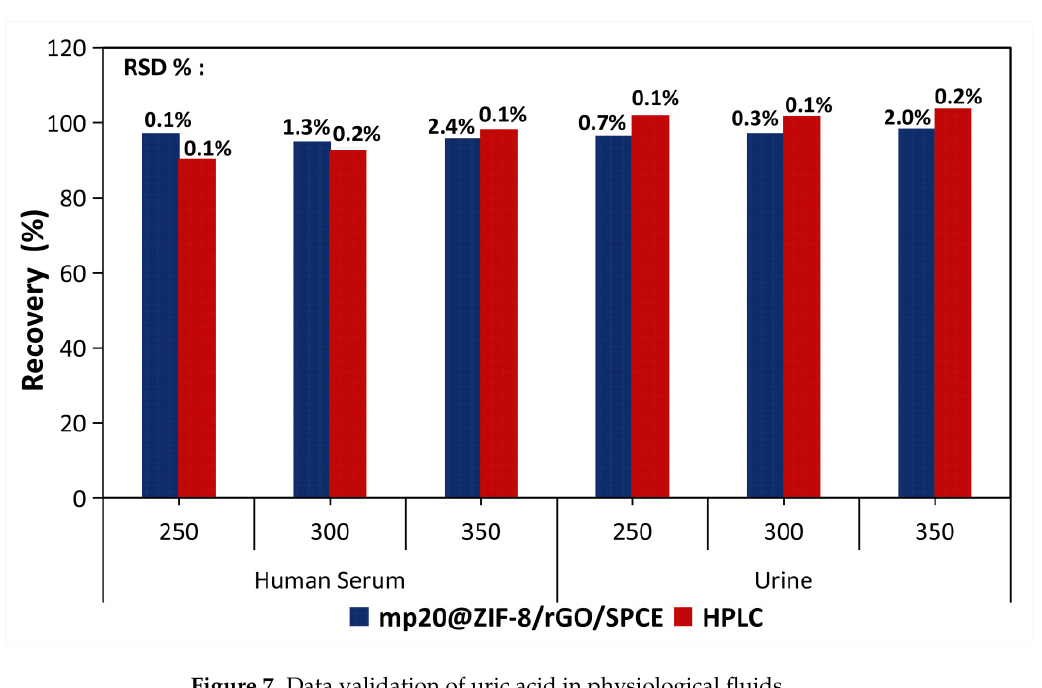
Figure 7. Data validation of uric acid in physiological fluids.